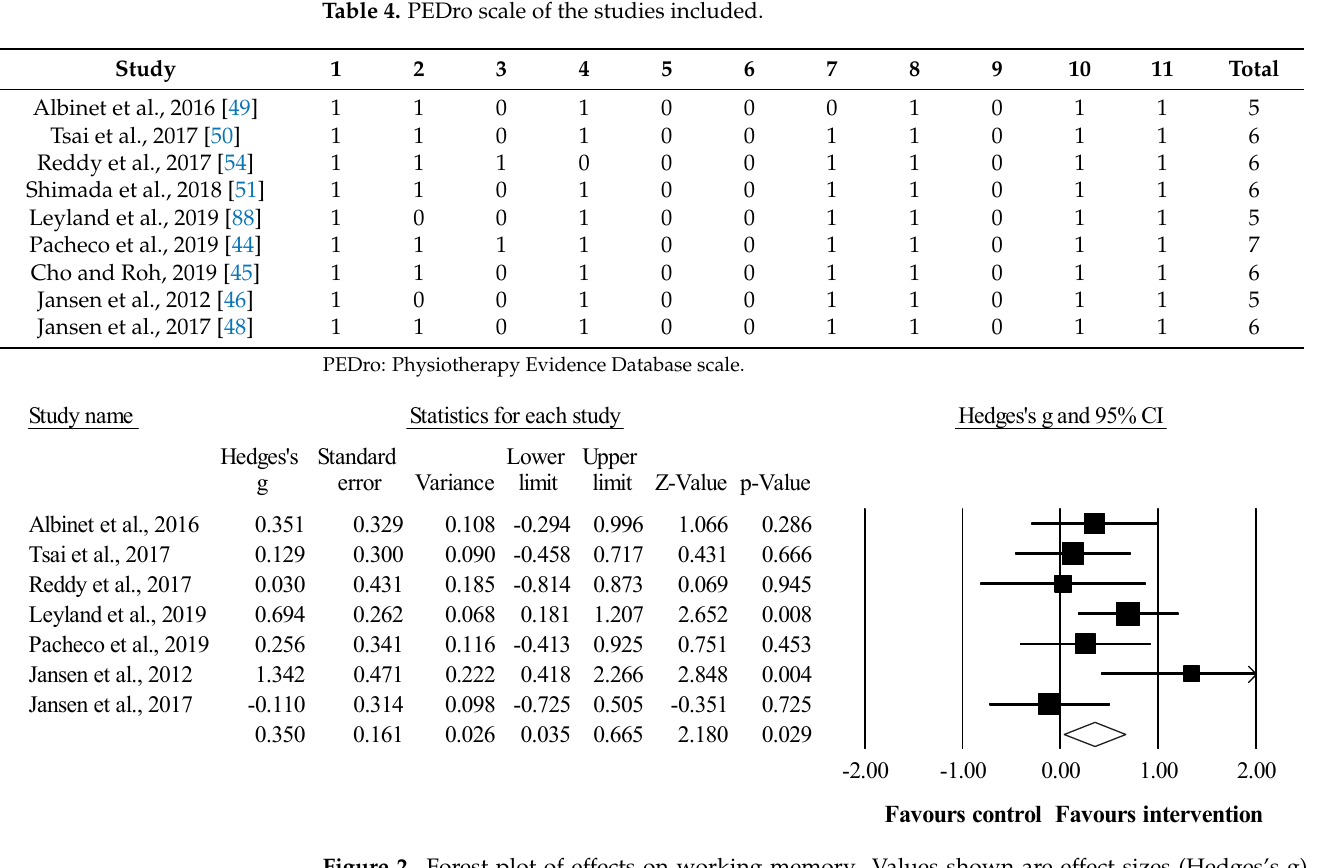
The meta-analysis for inhibition involved five studies, five experimental groups ( n = 108), and five control groups ( n = 87). Compared to the control group, the intervention had a small favoring but no signi fi cant e ff ect (ES = 0.20, 95% CI = − 0.42–0.84; p = 0.517; I 2 =